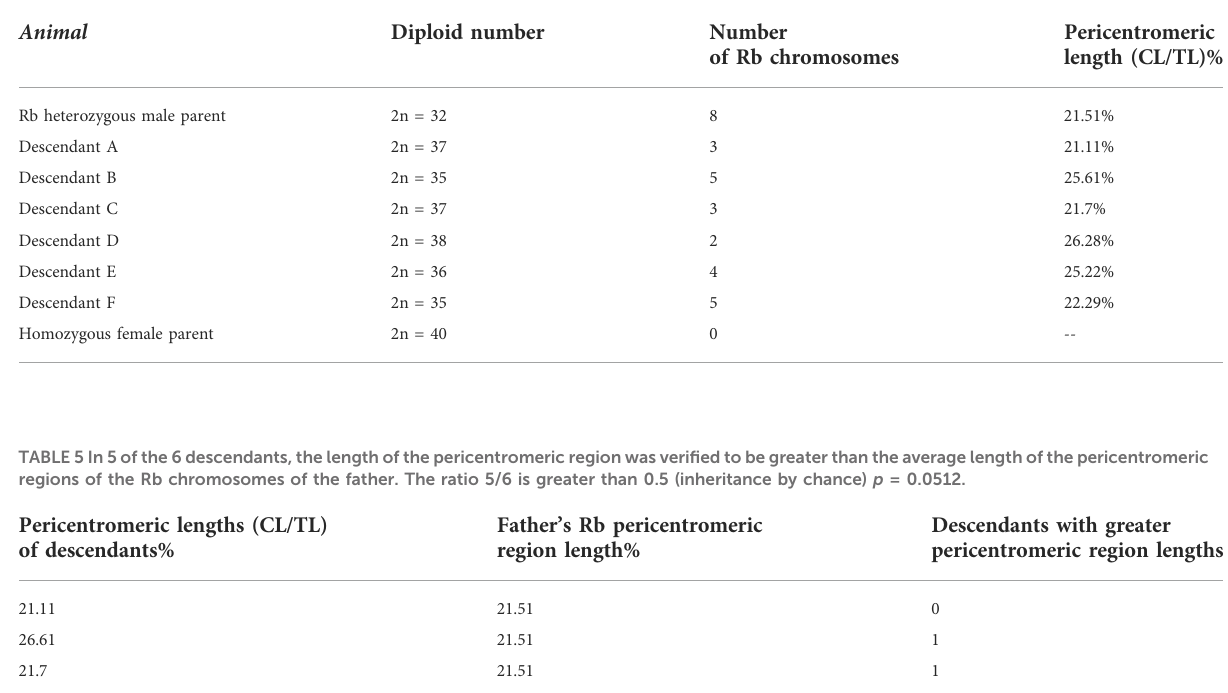
TABLE 4Diploid number,Rbchromosomes andlengths ofthe pericentromericregionsofRbchromosomesin themembersofafamilycomposed by a multiple Rb heterozygous male and a homozygous female 2n = 40 and their six offspring. The length of the centromeric region (CL) was measured in pixels and normalized with respect to the chromosomal total length (CL/TLx100).